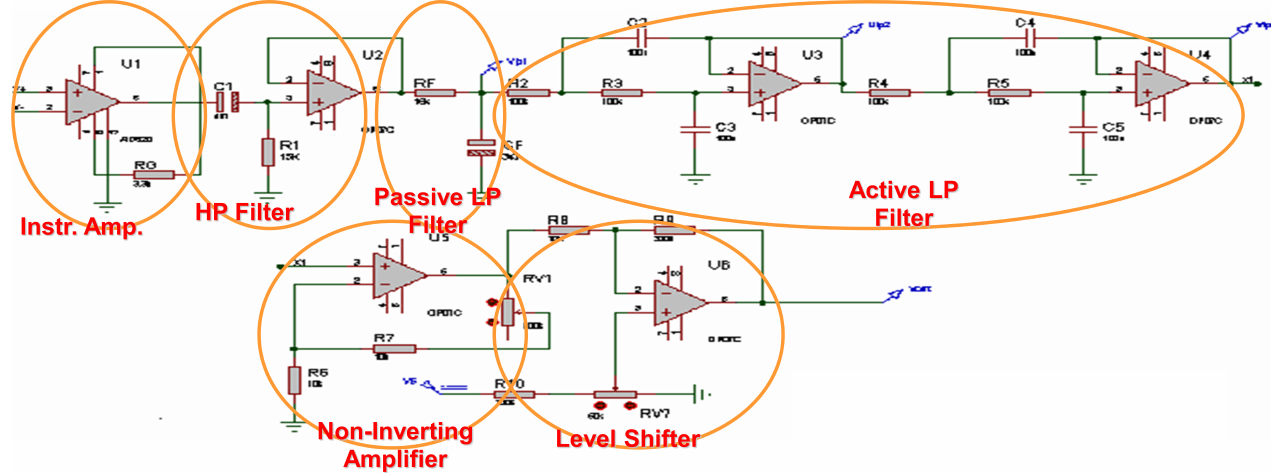
Fig. 3. The block diagram of the main participants of the designed ampli¯er in one